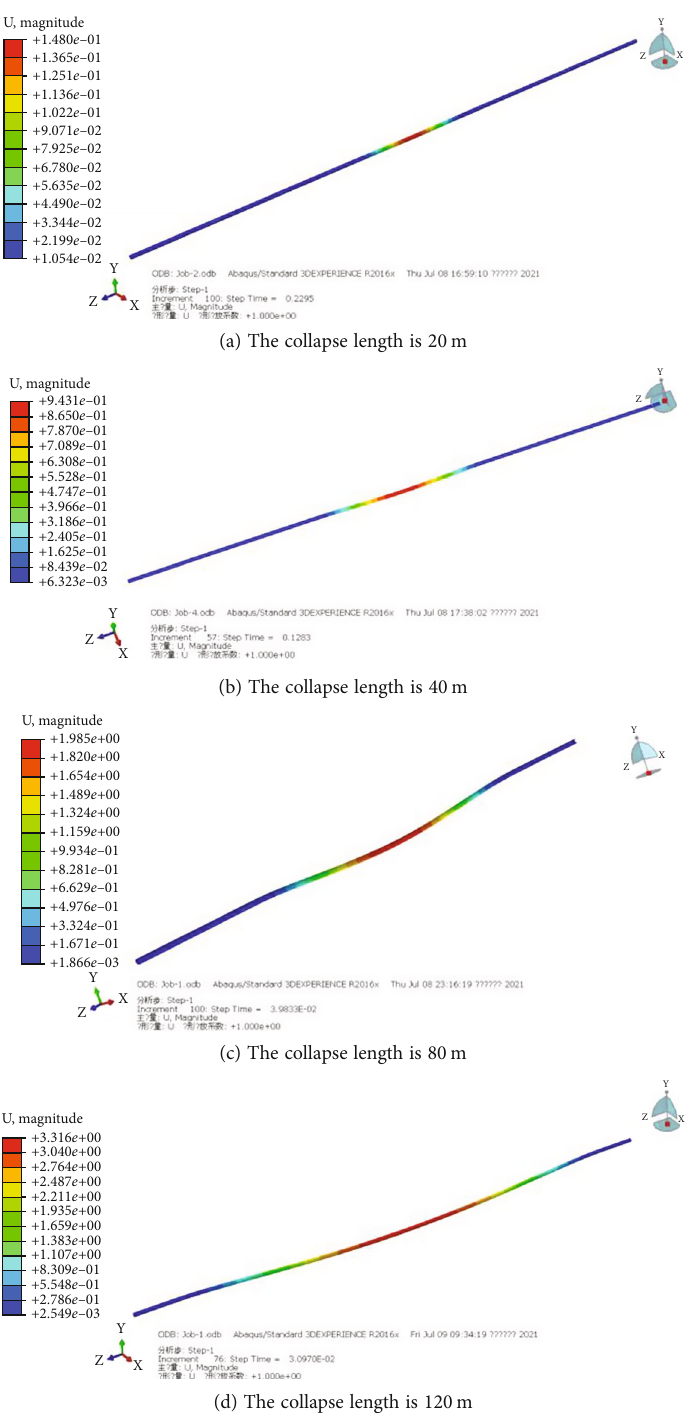
Figure 5: The pipeline ultimate deformation under di ff erent collapse